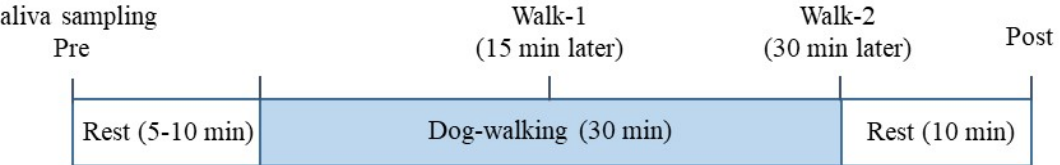
Figure 1. Schedule of four saliva samplings (Pre, Walk-1, Walk-2, and